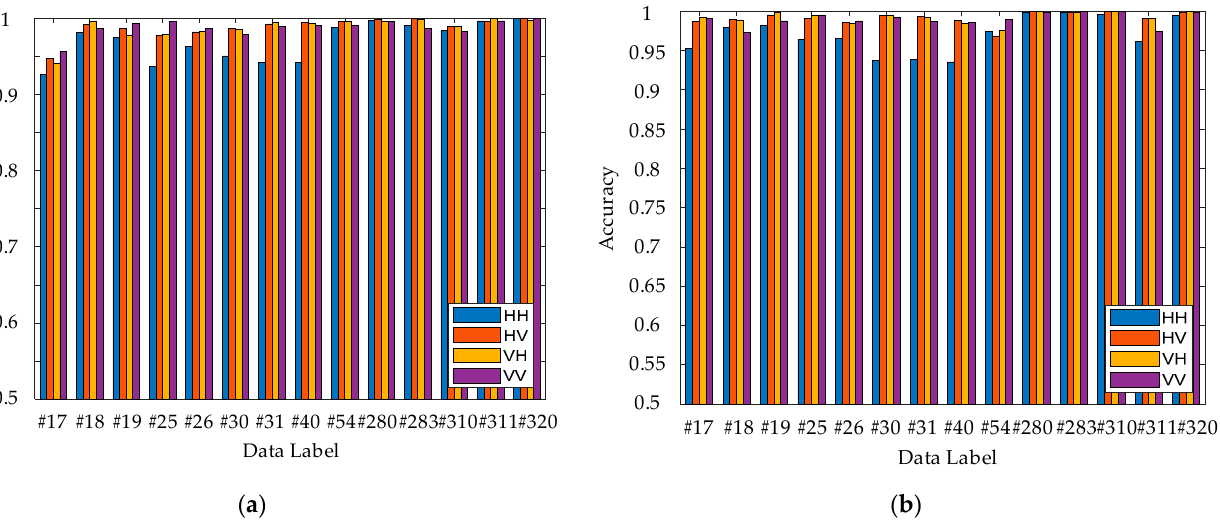
Figure 11. Detection results by CA ‐ EfficientNet ‐ B0 model: ( a ) GADF coding; ( b ) GASF coding.